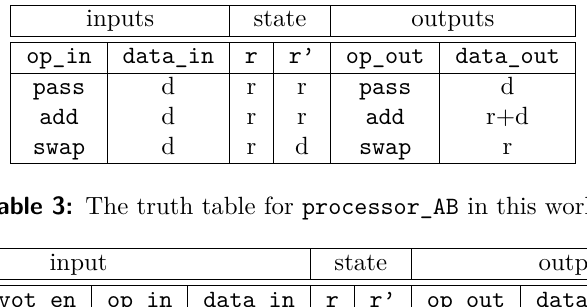
Table 2: The truth table for processor_B . The symbol r’ denotes the new register value in the next cycle.